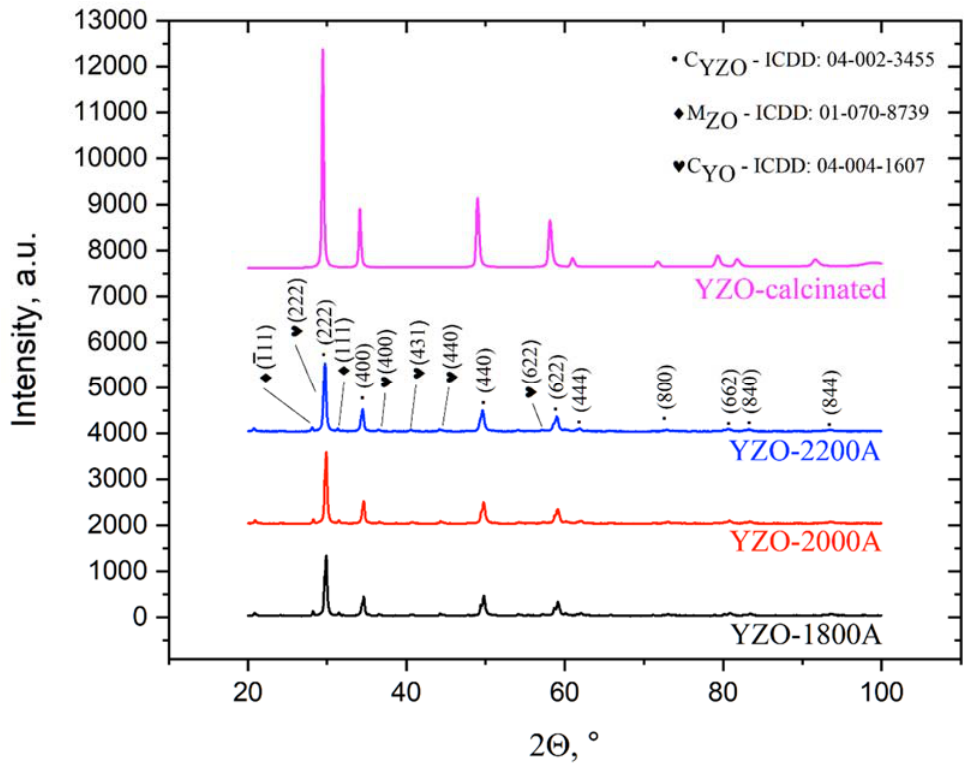
Figure 3. XRD patterns of the Yb 2 Zr 2 O 7 coating deposited in the reactive PS-PVD process using different power currents I = 1800, 2000, and 2200 A) and calcinated at 1500 °C mixture of ZrO 2 and Yb 2 O 3 powders (YZO-calcinated).